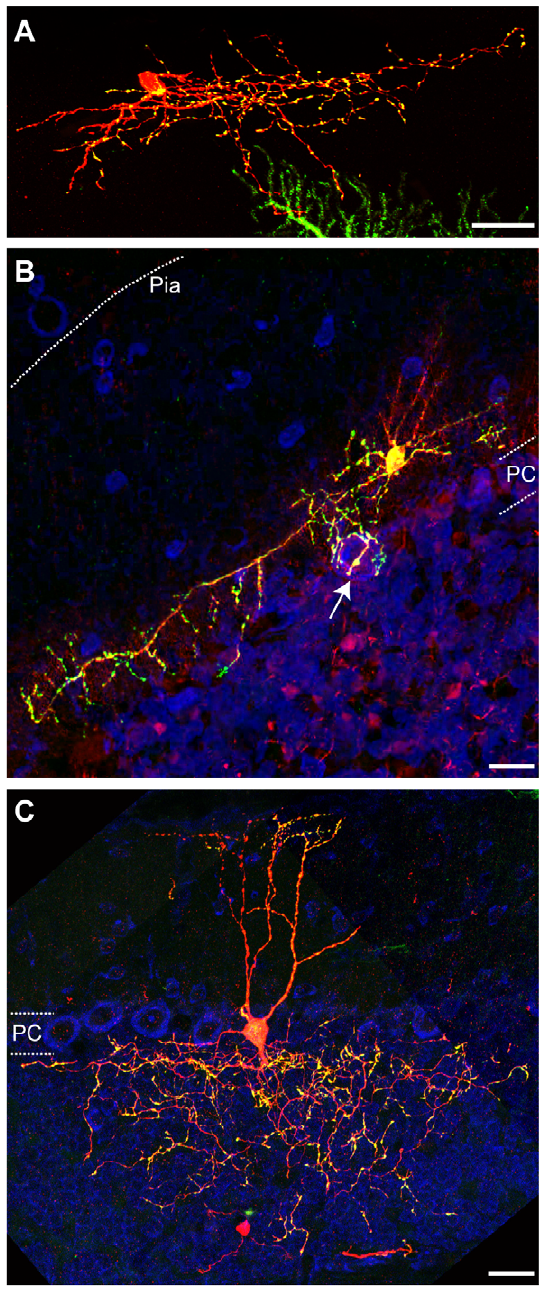
Figure 6. Morphology and presynaptic distribution in cerebellar interneurons. Representative images of Syp-GFP distribution in a cerebellar stellate cell (A), basket cell (B) and Golgi cell (C). Syp-GFP (green), tdT (red), TOTO3 (blue). White dashed lines (B) highlight the PC layer (estimated by the TOTO3 signal of PC bodies) and the pial surface. Arrow points to a ‘‘basket.’’ Labeled GC axons in (B) were removed for presentation purposes using Photoshop. White dashed lines (C) highlight the PC layer in the cerebellum (estimated by the TOTO3 signal of PC bodies). All cells are from triple transgenic mice (ZtTA/wt; TRE-Bi-SG-T/wt; b -actin-CreER/wt)dissected at P21(A), P30(B)andP15 (C). Tamoxifen was administered at E9.5 (A), P7 (B) and E17.5 (C). Scale bars are 20 m m.